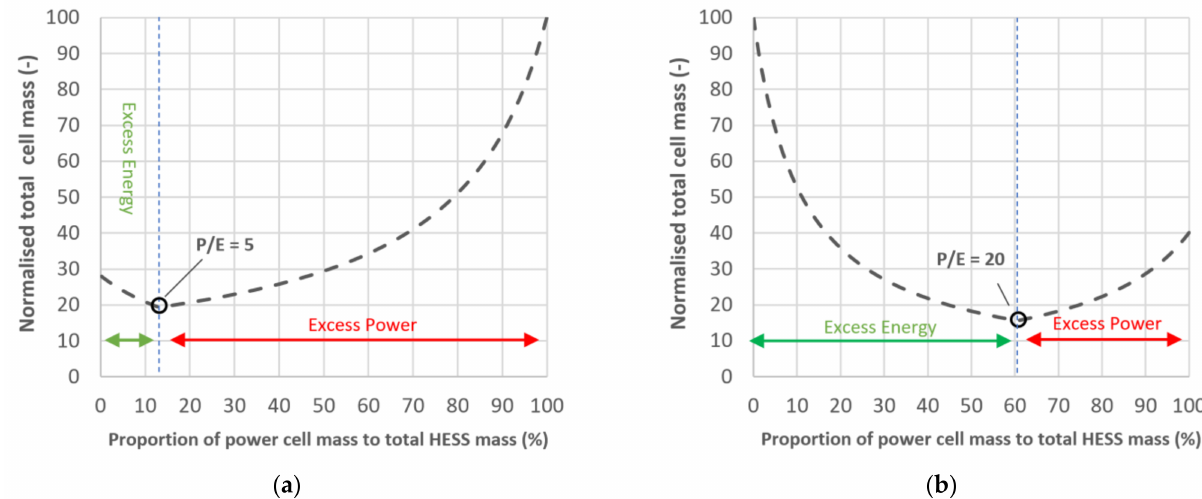
Figure 3. Total cell mass curves for different power-cell-to-total-cell mass ratios highlighting the optimal ratio to achieve exact power and energy targets based on a 400 Wh/kg energy cell and an 8 kW/kg power cell: ( a ) PE ratio target of 5 and ( b ) PE ratio target of